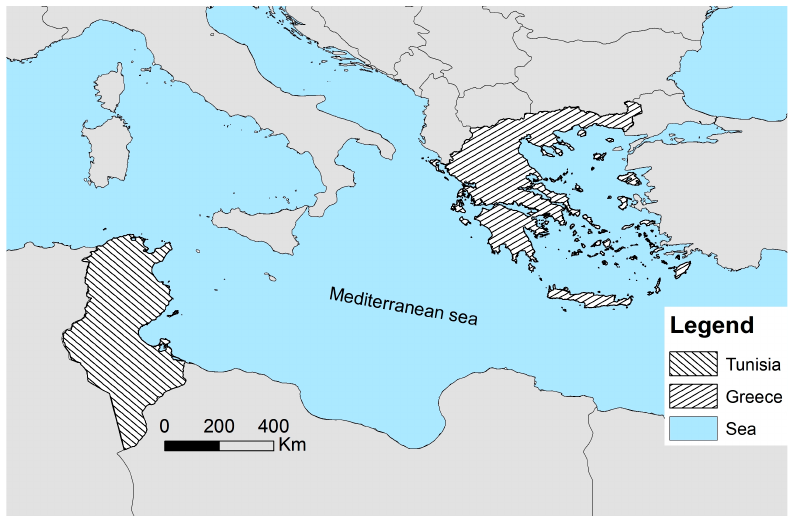
Figure 1. Location of the study areas.